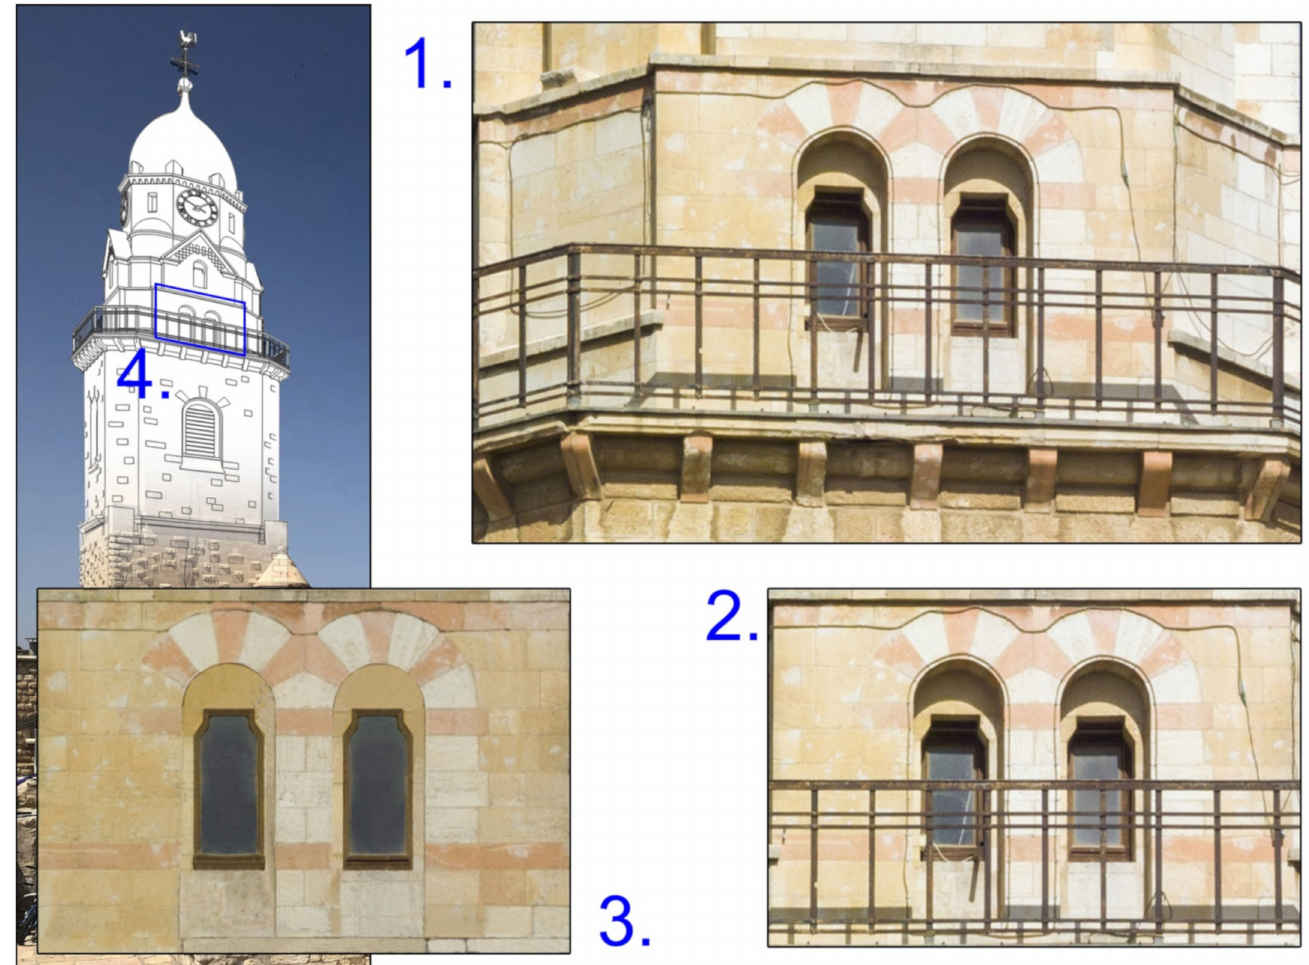
Figure 11. Steps for developing a bitmap corresponding to the basilica tower surface. Computer software that allows for defining bitmap-based reflectance and transmit- tance of materials typically calculates average and maximum values for reflectance or transmittance. Figure 13 shows Autodesk 3ds Max 2021 Material Editor with the read section highlighted for reflectance and transmittance of materials. For the Dormition of the Blessed Virgin Mary Basilica, only the reflectance was subject to analysis, as there are no transparent materials to be illuminated. Still, the way the parameters are defined holds. It should be noted that material properties defined this way, i.e., as based on photographs, could be highly erratic and proper care should be taken to avoid it. For example, for a picture of a white wall, the raster image is represented by a hue with a value of 255 for each RGB component, so it leads to a perfect white with a reflectance of 1 (Figure 13a). The software then indicates an anomaly with a red or blue value for overrated and underrated parameters, respectively. It is up to designers to rely on the real measurements rather